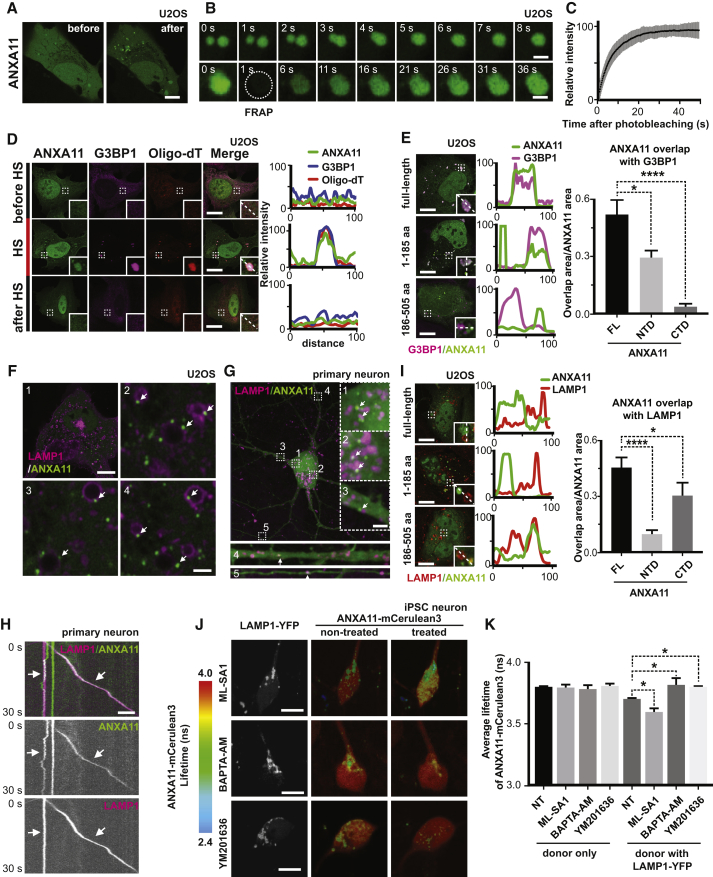
ANXA11 Interacts with Both RNA Granules and Lysosomes in Living Cells(A–D) ANXA11 interact with RNA granules in cells(A) ANXA11-mEmerald redistributes from the cytoplasm into dispersed puncta immediately following heat shock (43oC) in U2OS cells. Scale bar: 20 μm. See also Figure S3A.(B) Heat shock induced ANXA11-mEmerald puncta in U2OS cells are motile and undergo fusion (upper panel), and recover rapidly after photobleaching (i.e., FRAP)(bottom panel). Scale bar: 1 μm. See also Figure S3B.(C) Quantification of FRAP experiment in (B), n=23. Error bars = SEM. See also Figure S3C.(D) Immunostaining of mEmerald-tagged ANXA11 with RNA granule markers (Cy3-Oligo dT(30), anti-G3BP1) before, during and 4 hours after heat shock (HS) in U2OS cells. Line scans show the related intensity profiles of ANXA11 with mRNA (Cy3 Oligo-dT) and with G3BP1. Scale bar: 30 μm. See also Figure S3D.(E) Immunostaining of mEmerald-tagged ANXA11 full-length, N-terminal or C-terminal domain and G3BP1 following 30 minutes of heat shock (43oC) in U2OS cells. Line scans show the related intensity profiles of ANXA11 with G3BP1. Scale bar: 30 μm. Right panels show the quantification of ANXA11 tructation area overlap with G3BP1(relative to ANXA11 area). One-way ANOVA, ∗p < 0.05, ∗∗∗∗p < 0.0001, n=10. Error bars = SEM. Scale bar: 30 μm. See also Figures S3E, S3F.(F–K) ANXA11 puncta interact with lysosomes in cells(F) Panel 1: Live cell imaging of U2OS cells expressing ANXA11-mEmerald and LAMP1-HaloTag following heat shock at 43oC in U2OS cells. Panels 2-4: Enlarged areas of panel 1, with arrows pointing to ANXA11/lysosome contact sites (Scale bar: 1 μm). See also Figure S3H.(G) Rat cortical neurons expressing LAMP1-HaloTag and ANXA11-mEmerald imaged after heat shock. ANXA11 puncta co-localized with lysosomes in different neuronal regions: soma (1,2), dendrite (3,4) and axon (5). Arrows point to contact sites between lysosomes and ANXA11 puncta. Scale bar: 5 μm(H) Live imaging of rat cortical neuron axons expressing LAMP1-HaloTag and ANXA11-mEmerald. The corresponding kymograph shows ANXA11 puncta (green) either co-trafficking or co-localizing with lysosomes (magenta). Scale bar: 5 μm. See also Figure S3G.(I) Immunostaining of mEmerald-tagged ANXA11 full-length, N-terminal or C-terminal domain with LAMP1-positive lysosomes in U2OS cells following 30 minutes of heat shock (43oC). Line scans show related intensity profiles of ANXA11 and LAMP1. Scale bar: 30 μm. Far right panel shows the quantification of ANXA11 trucations and LAMP1 co-localization (relative to ANXA11 area). One-way ANOVA, ∗p < 0.05, ∗∗∗∗p < 0.0001, n=10. Error bars = SEM. Scale bar: 30 μm.(J) FLIM-FRET analysis of the interaction between ANXA11 and lysosomes and its regulation by lysosomal Ca2+ and PI(3,5)P2. Human i3Neurons were transduced with ANXA11-mCerulean3 (FRET donor) and LAMP-YFP (FRET acceptor). FLIM-FRET images were acquired for the same neurons before and after treatment with ML-SA1, BAPTA-AM or YM201636, and the lifetime of the ANXA11-mCerulean3 signal was determined. Left vertical panels show intensity images of LAMP1-YFP with the various treatments. Middle and right panels show ANAX11-mCeurlean3 lifetimes before and after drug treatment.(K) Quantification of FLIM-FRET lifetime measurements from (H). N=31 (NT), 24 (ML-SA1), 20 (BAPTA-AM), 24 (YM201636). One-way ANOVA, ∗p < 0.05. Error bars = SEM.